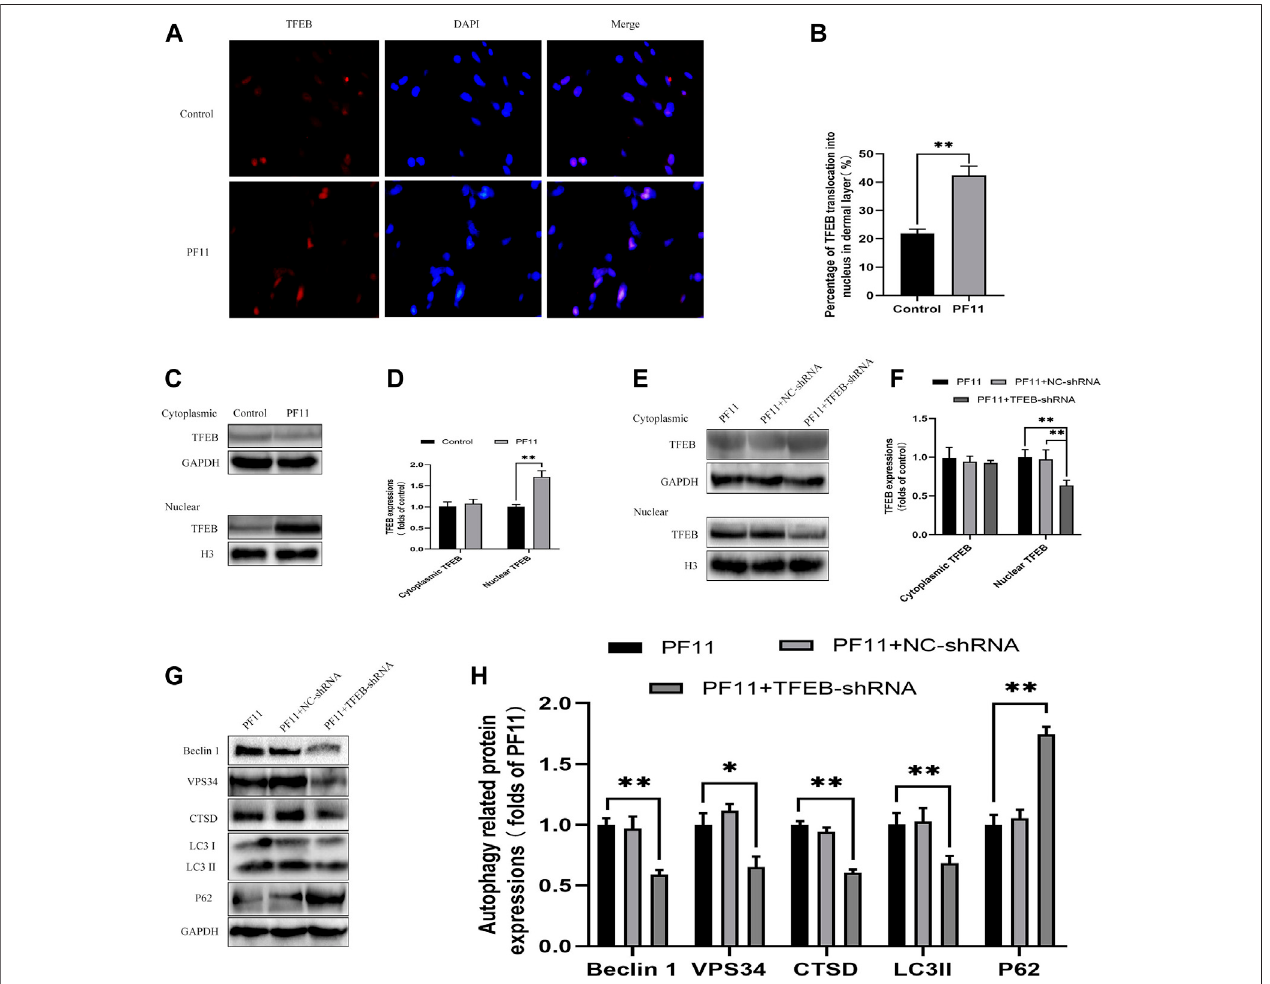
FIGURE 7 | PF11 augments autophagy by promoting nuclear translocation of TFEB. (A,B) Immuno fl uorescence staining for nuclear translocation of TFEB (red) in cells of fl aps in the control and PF11 groups (scale bar, 20 μ m). (C,D) Western blotting was performed to assess the expression of cytoplasmic and nuclear TFEB in the controland PF11 group. (E,F) The level ofcytoplasmic and nuclearTFEB inthePF11, PF11 +NC-shRNA, and PF11+TFEB-shRNAgroups were evaluatedbywestern blottingassay (G,H) Westernblottingwasusedtoassesstheexpressionlevelofp62,Beclin1,VPS34,CTSD,andLC3IIinthePF11,PF11+NC-shRNA,andPF11 + TFEB-shRNA groups. Cropped blots are shown. Values are expressed as means ± SD, n (cid:2) 6 per group. * p < 0.05 and ** p < 0.01, vs. PF11 group.